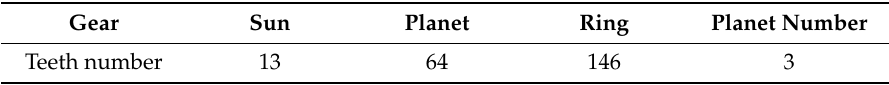
Table 2. Gear parameters of the single-stage planetary gearbox.